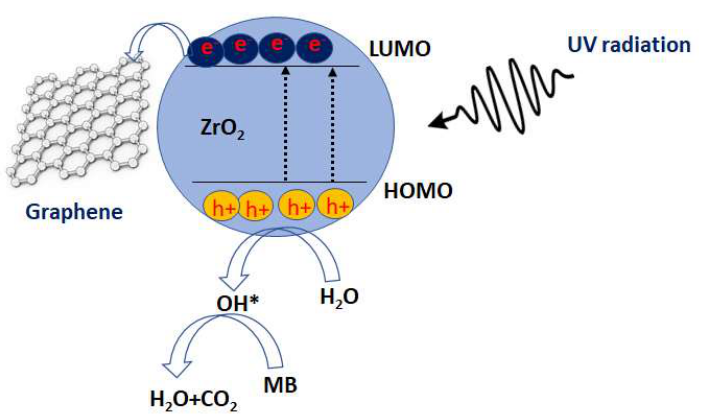
Figure 8. Effect of the contact time on the degradation capacity of methylene blue (MB) concentration vs. irradiation time in the presence of ZrO 2 , ZrO 2 /G5, and ZrO 2 /G10 for both concentrations of MB of: ( a ) 5.0 and ( b ) 10.0 mg/L.